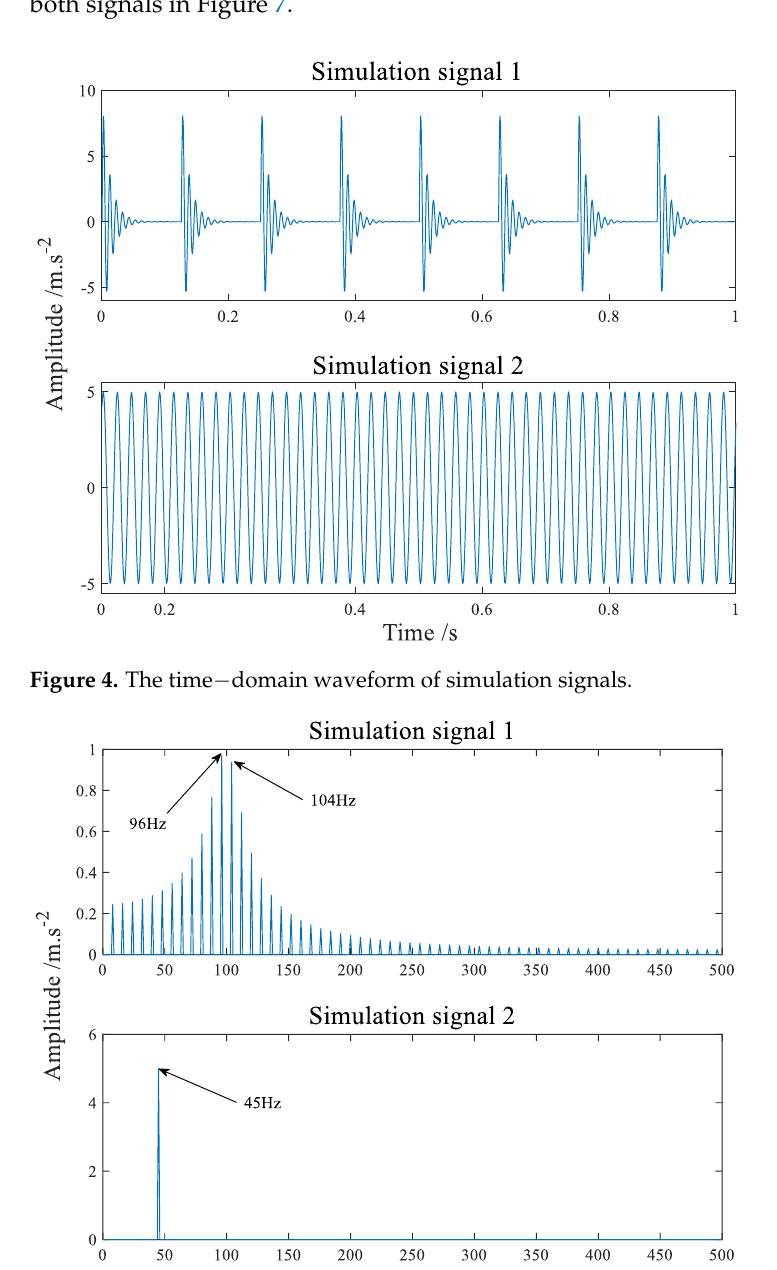
Figure 6. The time − domain waveform of mixed signals. Figure 7. The amplitude spectrum of mixed signals. The separated signals recovered by the SMF − DPC − OMP algorithm are shown in Fig- ures 8 and 9, showing its time-domain waveform and amplitude spectrum, respectively.